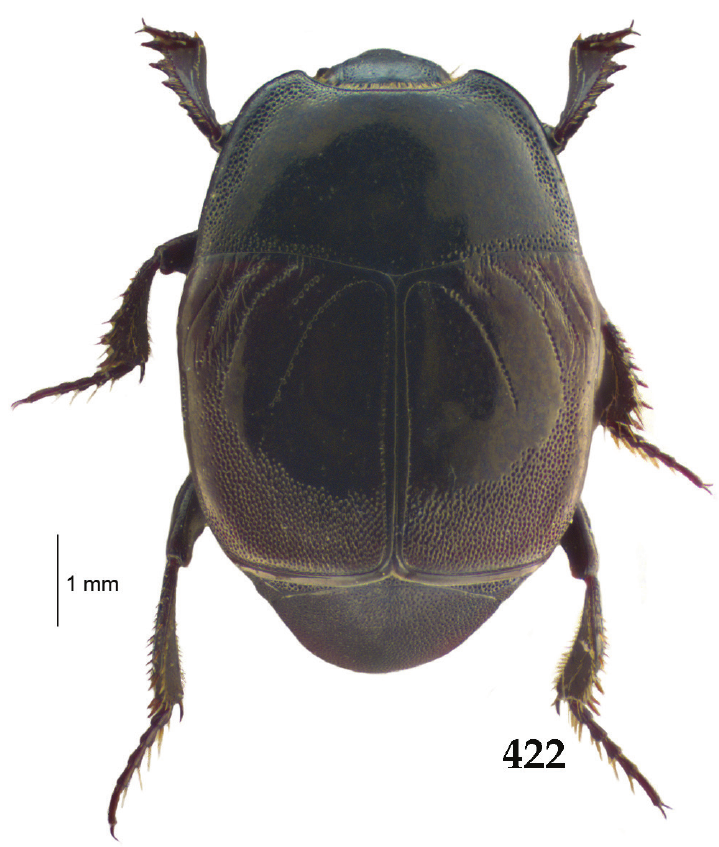
Figure 422. Saprinus ( Saprinus ) detritus (Fabricius, 1775) habitus, dorsal view. / detritus F. / det. J.C.Watt / (Saprinus) 1985” (printed written); followed by a label with a QR code and “NHMUK010601207” (printed) (BMNH). Saprinus antipodus Dahlgren, 1971: Holotype, ♂ , originally pinned, glued to a rectangular mounting card, genitalia extracted, glued onto the same card as the speci- men, with the following labels: “Neu-Seeland” (written); followed by: “pseudocyaneus / Bickhardt” (written); followed by: “MUSÉUM PARIS / 1933 / Coll. Desbordes” (printed); followed by: “Saprinus / antipodus / Dahlgren, 1971 / HOLOTYPE / det. T. Lackner ‘17” (red label, written) (MNHN). Dahlgren (1971) described the species based on a single male, describing its labels exactly. The specimen found at MNHN completely agrees with Dahlgren’s description and is thus the holotype by inference. Additional material examined. NEW ZEALAND. North Island. ND: 1